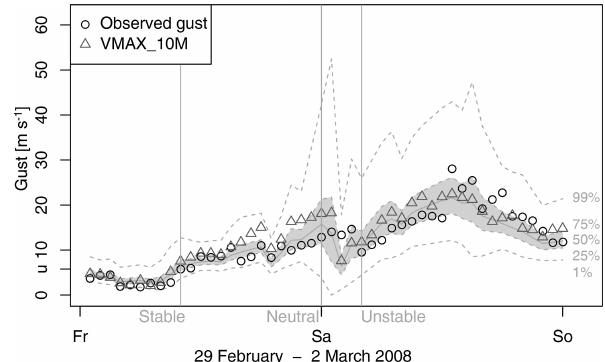
Figure 9. Post-processing of gusts on 29 February and 1 March 2008 at 10m. Shading indicates the predictive interquar- tile range, the grey line indicates the median, and dashed lines indi- cate the 1% and 99% quantiles respectively. The observed gust are shown as circles, and the 10m gust diagnostic is shown as triangles. The vertical lines indicate times with stable (LI of 8.7K), neutral (LI of 2.4K), and unstable (LI of − 3 . 1K)